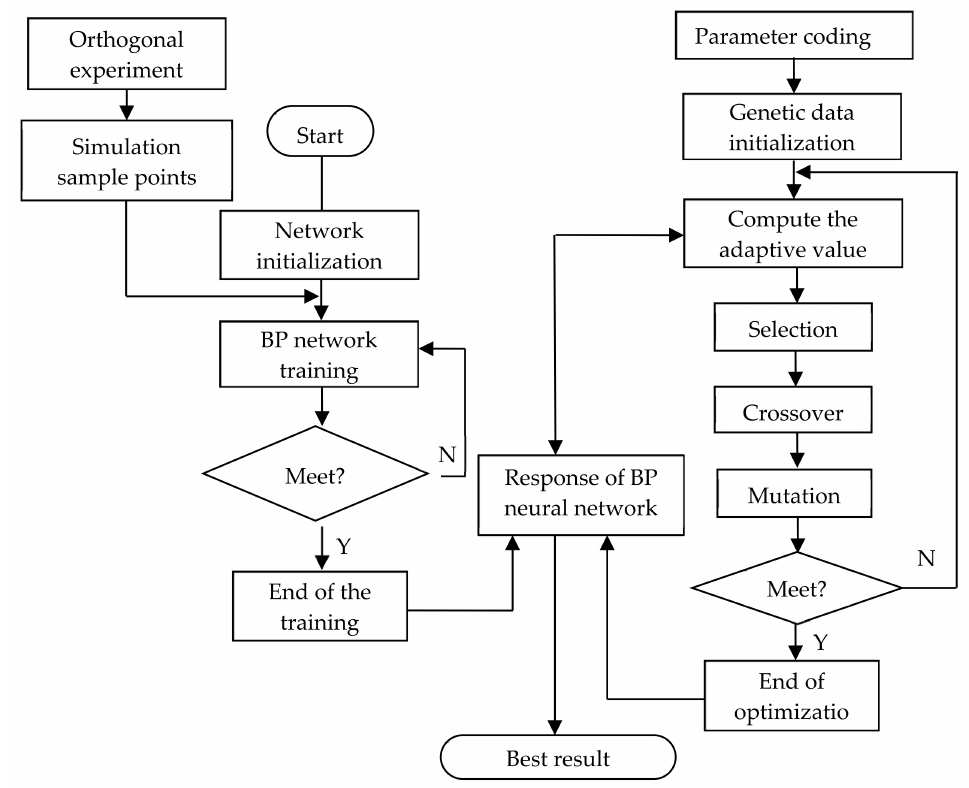
Figure 1. Optimized flow diagram between BP neural network and